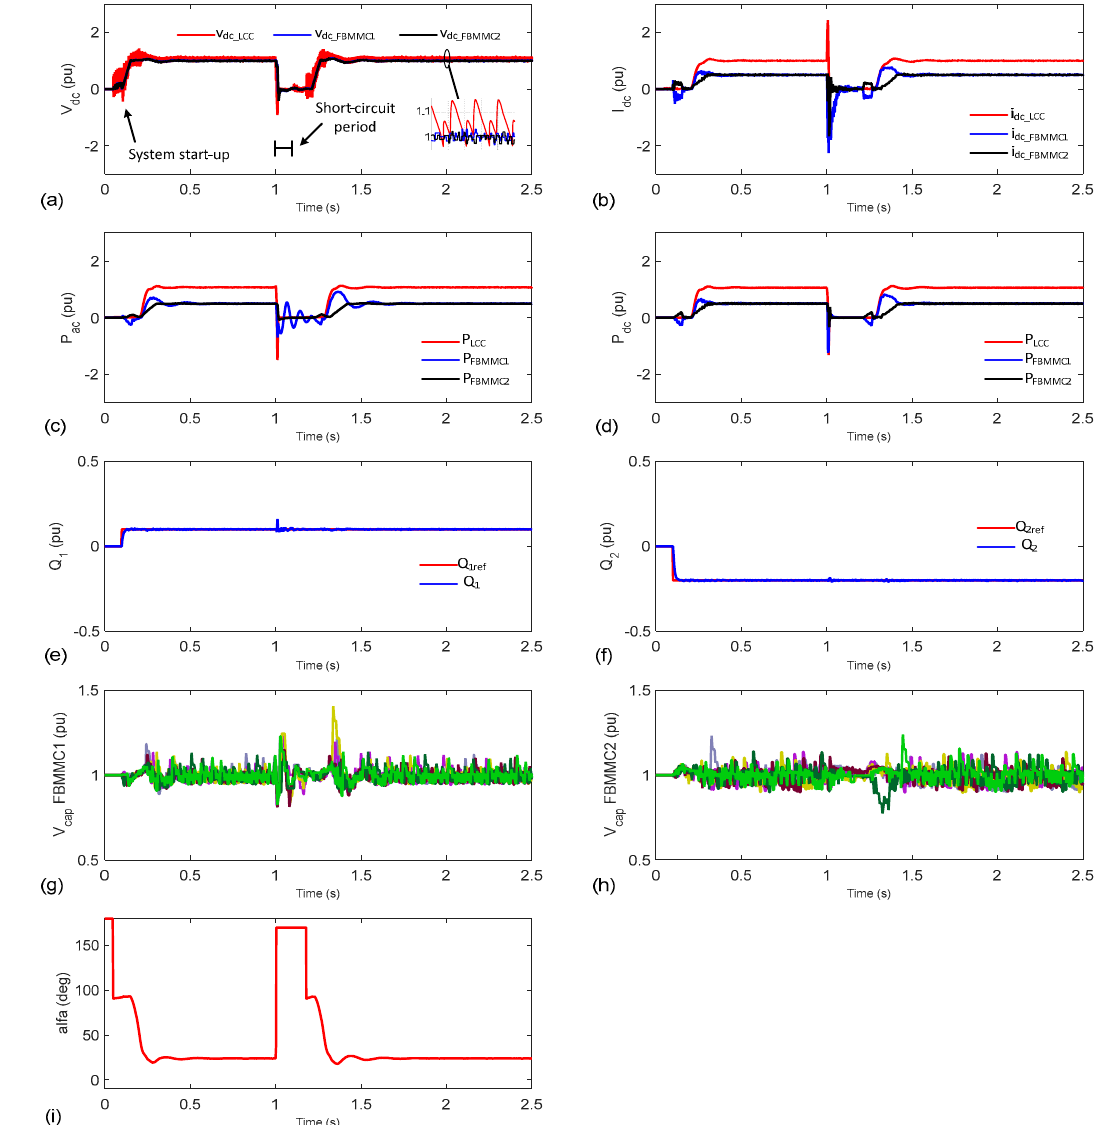
Figure 13. System behavior during a DC fault: ( a ) DC voltages; ( b ) DC currents; ( c ) AC active power; ( d ) DC active power; ( e ) reactive power at the AC grid connected to FBMMC1; ( f ) reactive power at the AC grid connected to FB2; ( g ) FBMMC1 capacitor voltages; ( h ) FBMMC2 capacitor voltages; ( i ) CSC firing angle α or .